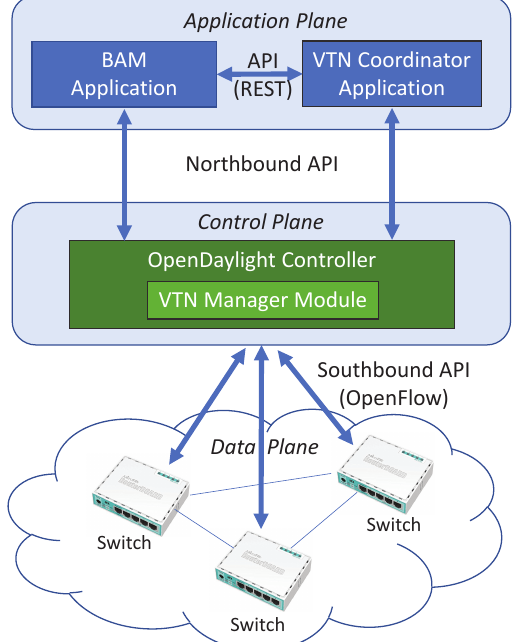
Figure 1. The proposed SDN-based network